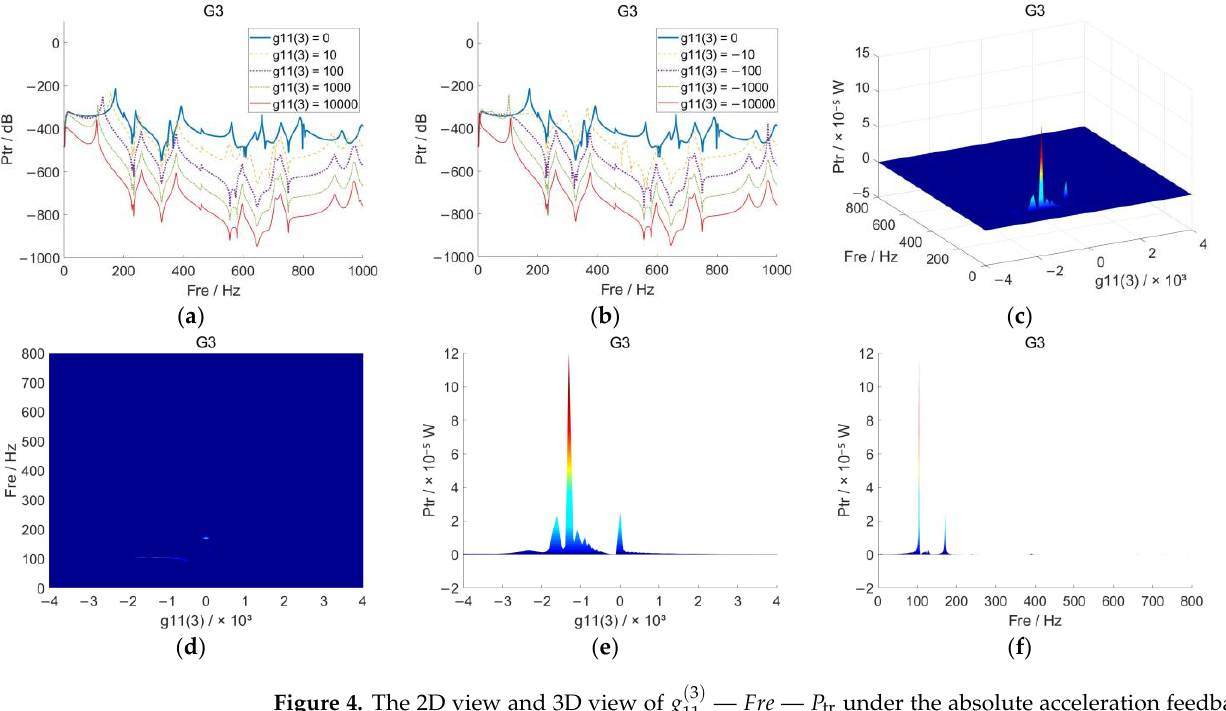
( 2 ) P under the absolute velocity feedback control g — Fre — Figure 3. The 2D view and 3D view of ( ) 2 Figure 3. The 2D view and 3D view of g — Fre — P tr under the absolute velocity feedback control 11 tr 11 ( 2 ) P curves under ( ) 2 0 g  ∈ (cid:0) − 10 5 , 10 5 (cid:1) , the step size is set to 1 × 10 2 ): ( a ) comparison of P tr curves under method ( ( ) ( ,  − , the step size is set to 1 × 10 2 ): ( a ) comparison of method ( g 11 tr 11 ( 2 ) > 0; ( b ) comparison of P tr curves under g ( 2 ) < 0; ( c ) the 3D view of P tr curve under continuous P curves under ( ) 2 P curve under continuous variation g 0 g  ; ( c ) the 3D view of ; ( b ) comparison of 11 11 11 tr tr ( 2 ) variation of g ; ( d ) X-Y plane view; ( e ) X-Z plane view; ( f ) Y-Z plane view. 11